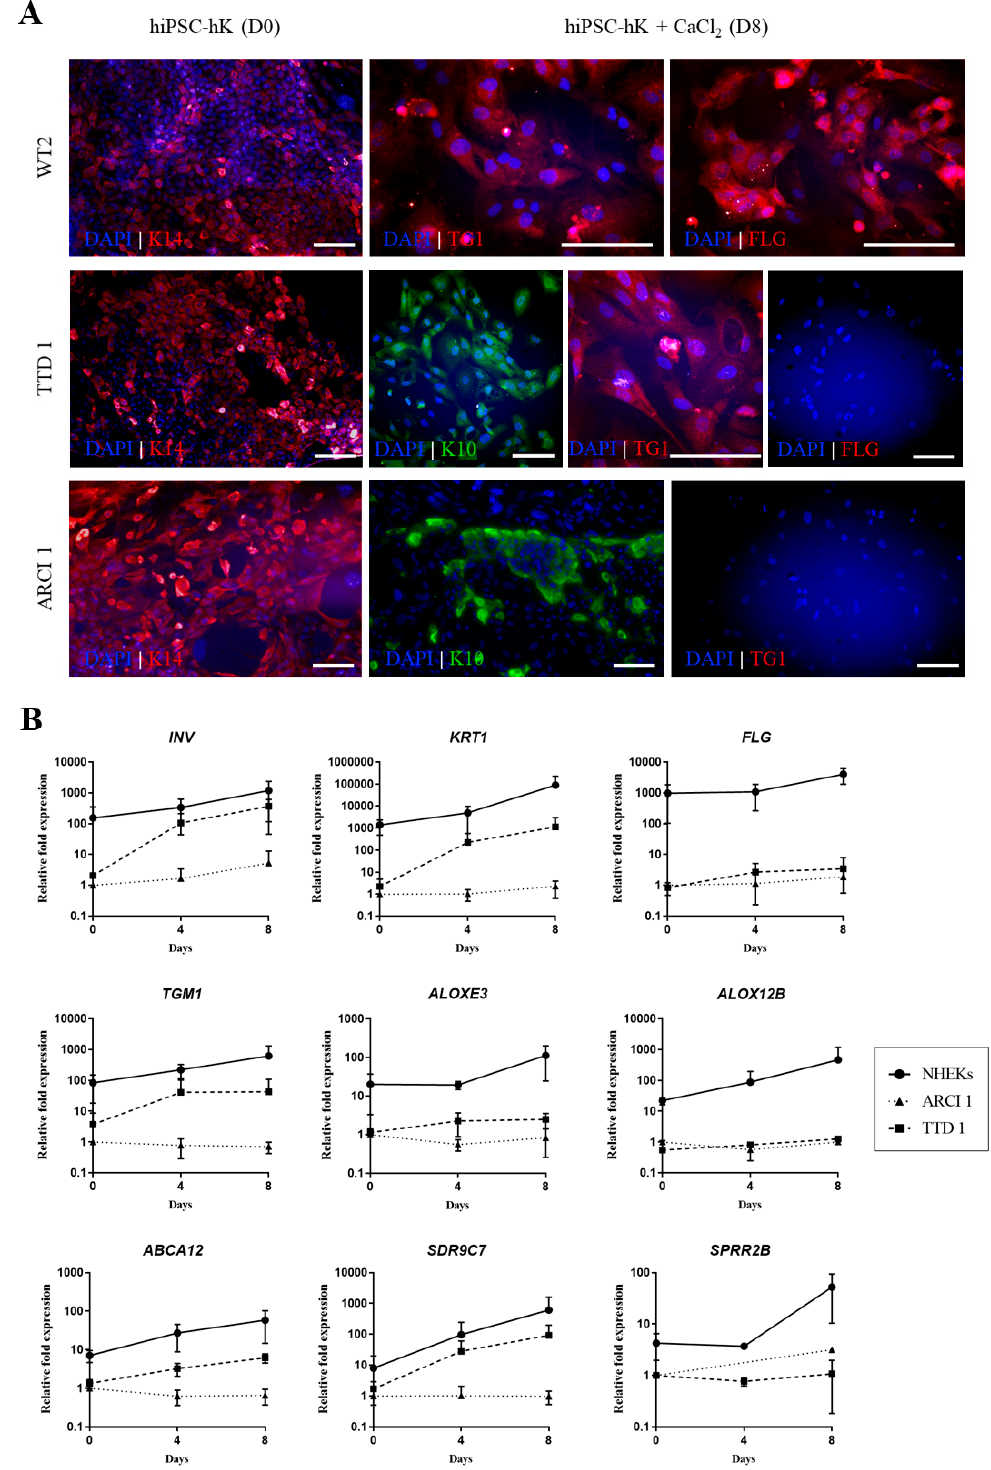
Figure 4. Calcium-induced terminal differentiation of patient-derived hiPSC-bKs. ( A ) Immunocytochemistry of basal keratinocytes marker keratin 14 (K14) and cornification proteins keratin 10 (K10), transglutaminase 1 (TG1) and filaggrin (FLG) in terminally differentiating control WT2 and ichthyosis patient TTD1 and ARCI1 hiPSC-derived keratinocytes. Scale bar 100 μ m. ( B ) Relative expression of several genes involved in the cornification process in both ARCI1 and TTD1. Calcium-exposed NHEKs were used as controls. All values were normalized to day 0 ARCI1 hiPSC-bKs with internal gene GAPDH used as reference.